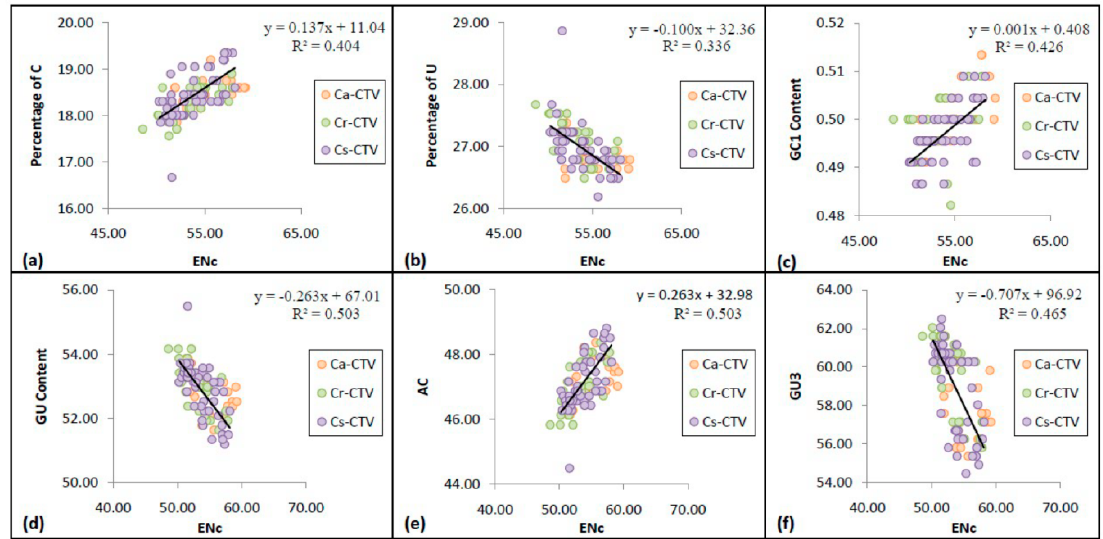
Figure 3. Correlations between effective number of codons (ENc) and the nucleotide composition of CTV coat protein gene. The relationship of ENc with C nucleotide content ( a ), U nucleotide content ( b ), GC1 content ( c ), GU content ( d ), AC content ( e ), and GU3 content ( f ). The regression curves can be described as y = 0.137 x + 11.04, R 2 = 0.404 ( a ); y = − 0.100 x + 32.36, R 2 = 0.336 ( b ); y = 0.001 x + 0.408, R 2 = 0.426 ( c ); y = − 0.236 x + 67.01, R 2 = 0.503 ( d ); y = 0.263 x + 32.98, R 2 = 0.503 ( e ); y = − 0.707 x + 96.92, R 2 = 0.465 ( f ). Different CTV subgroups are indicated with different color markers as shown to the right of the figure.